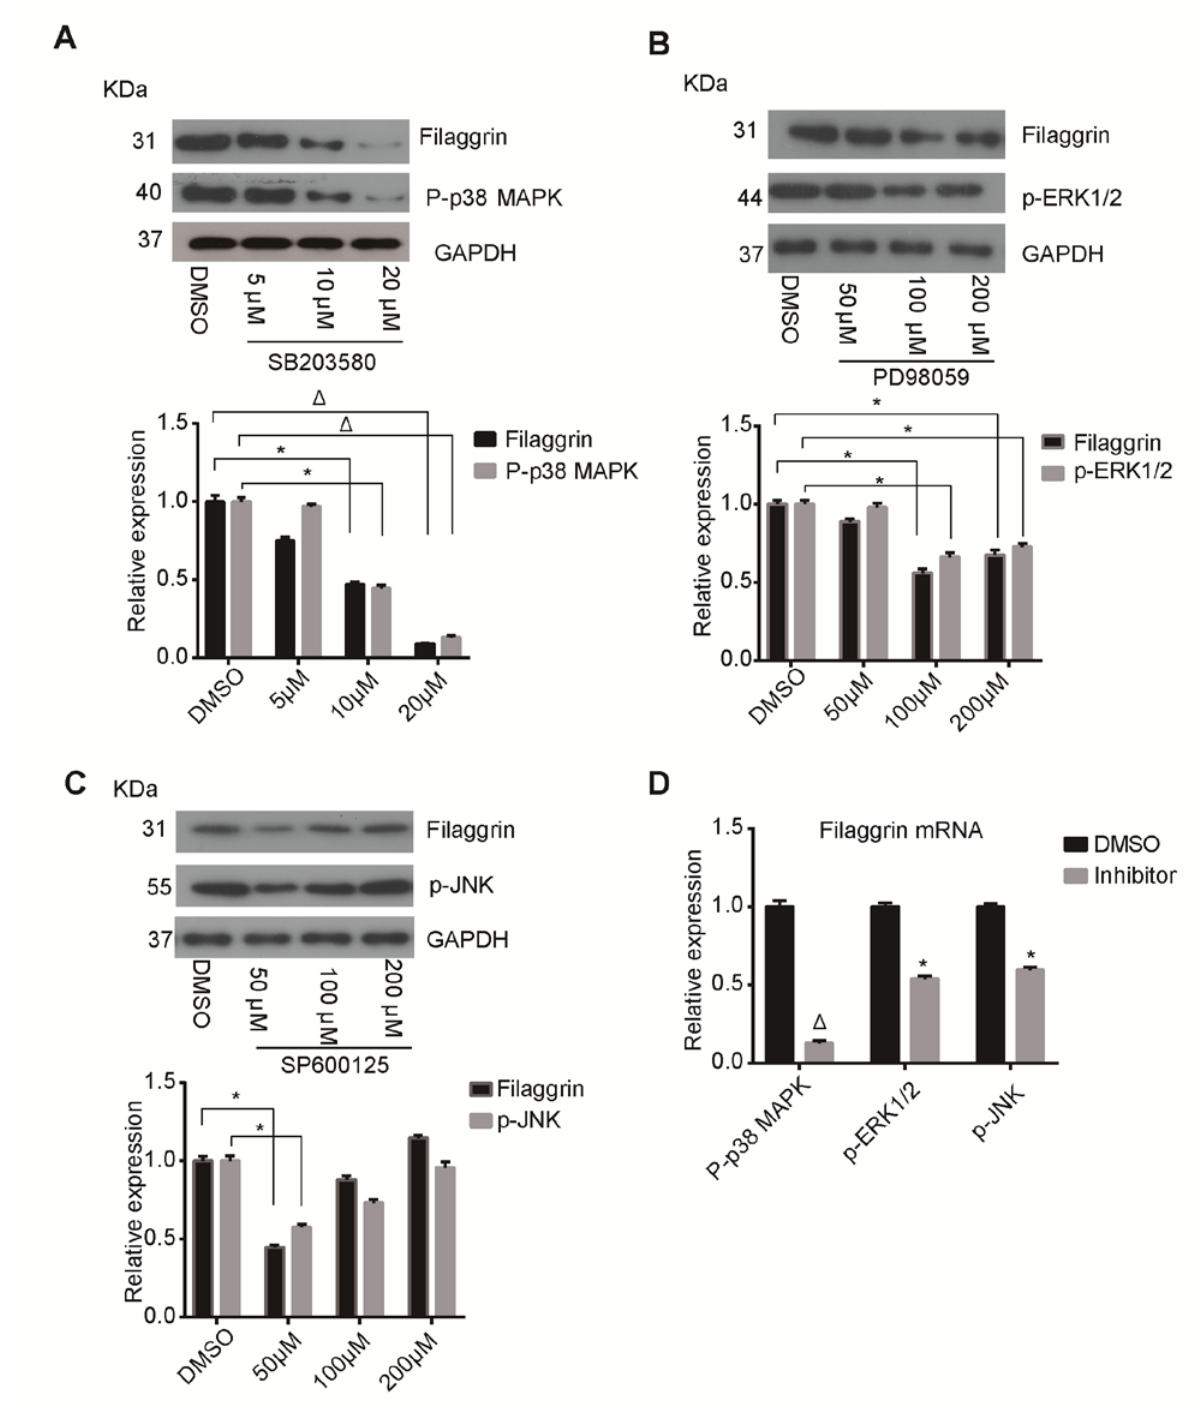
Figure 1: Inhibition of the p38, ERK1/2 and JNK pathways decreased the expression of filaggrin. A. Western blotting results of filaggrin (38 k Da), and p38. NHEKs were treated with SB203580 (p38 inhibitor) at 5 µ M, 10 µ M and 20 µ M for 24 h. DMSO treatment was used as control B. Western blotting results of filaggrin (38 k Da), and ERK1/2. NHEKs were treated with PD98059 (ERK1/2 inhibitor) at 50 µ M, 100 µ M and 200 µ M for 24 h. DMSO treatment was used as control. C. Western blotting results of filaggrin (38 k Da), and ERK1/2. NHEKs were treated with SP600125 (JNK inhibitor) at 50 µ M, 100 µ M and 200 µ M for 24 h. DMSO treatment was used as control. D. qRT-PCR results of expression of filaggrin mRNA in NHEKs cells treated with 20 µ M SB203580, 100 µ M PD98059 or 50 µ M SP600125, respectively. n = 3, * P < 0.05, Δ P <